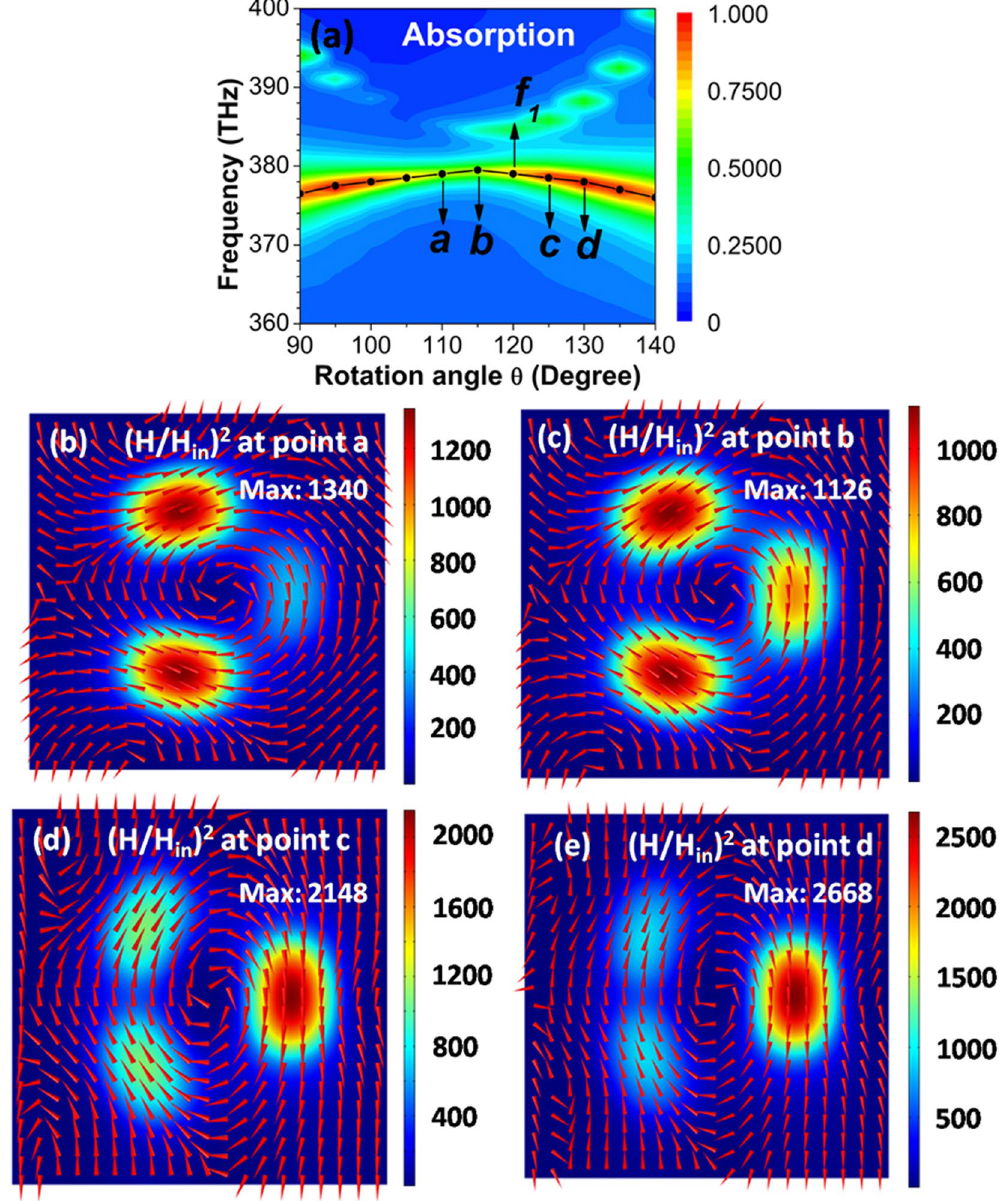
Figure 4. ( a ) Contour plot of absorption spectra of toroidal metamaterials as a function of light frequency and rotation angle θ at normal incidence. The overlaid black line and solid circles give the resonance position of toroidal dipolar mode. ( b – e ) Magnetic field distributions on the xy plane across the center of SiO 2 spacer, at a , b , c, and d points. Red arrows show the directions of magnetic fields, and colors give the intensity of magnetic